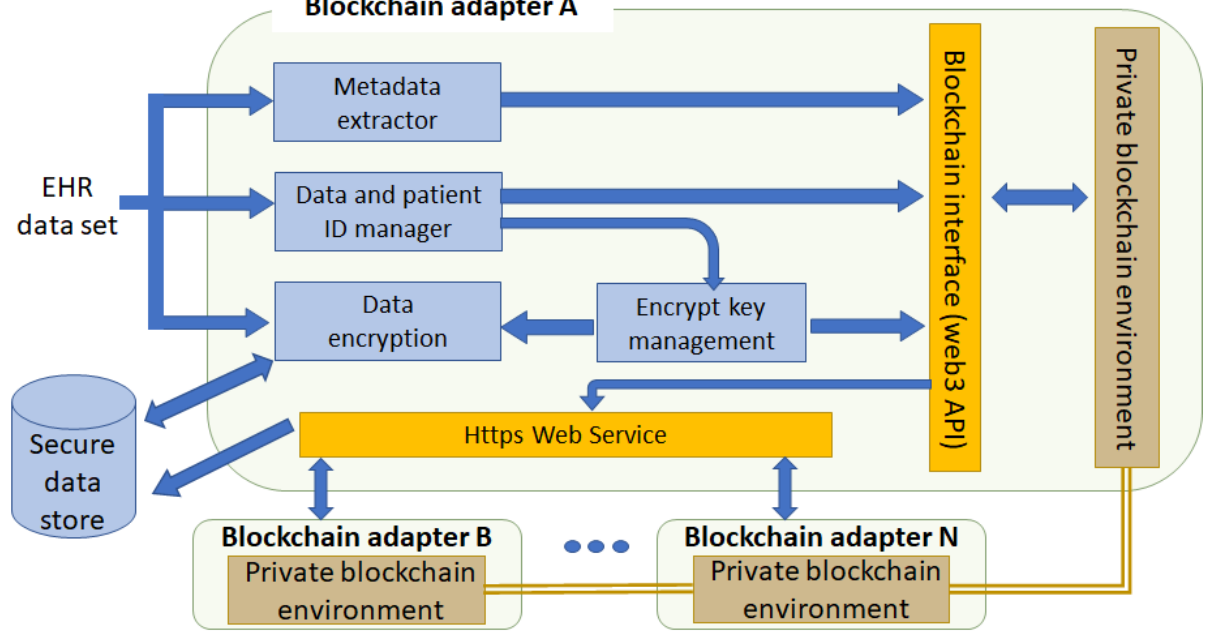
Figure 4. Blockchain adapter components and functions. Blockchain adapter extracts the metadata from the electronic health record, encrypts the electronic health record, stores the encrypted electronic health record into the secured data store, and maps the patient ID and data ID to the blockchain account. Blockchain adapters use https to interact with other adapters and communicate with the foundation private blockchain network through a blockchain interface. API: application program interface; EHR: electronic health